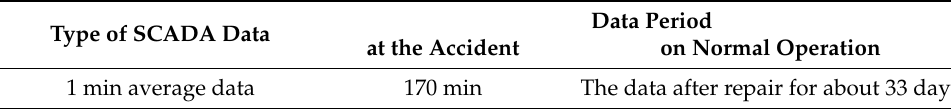
Table 2. Data acquisition period of SCADA data.